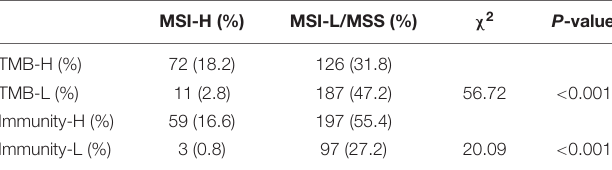
TABLE 1 | Correlations between tumor mutation burden, immune infiltrations, and microsatellite instability status in colon